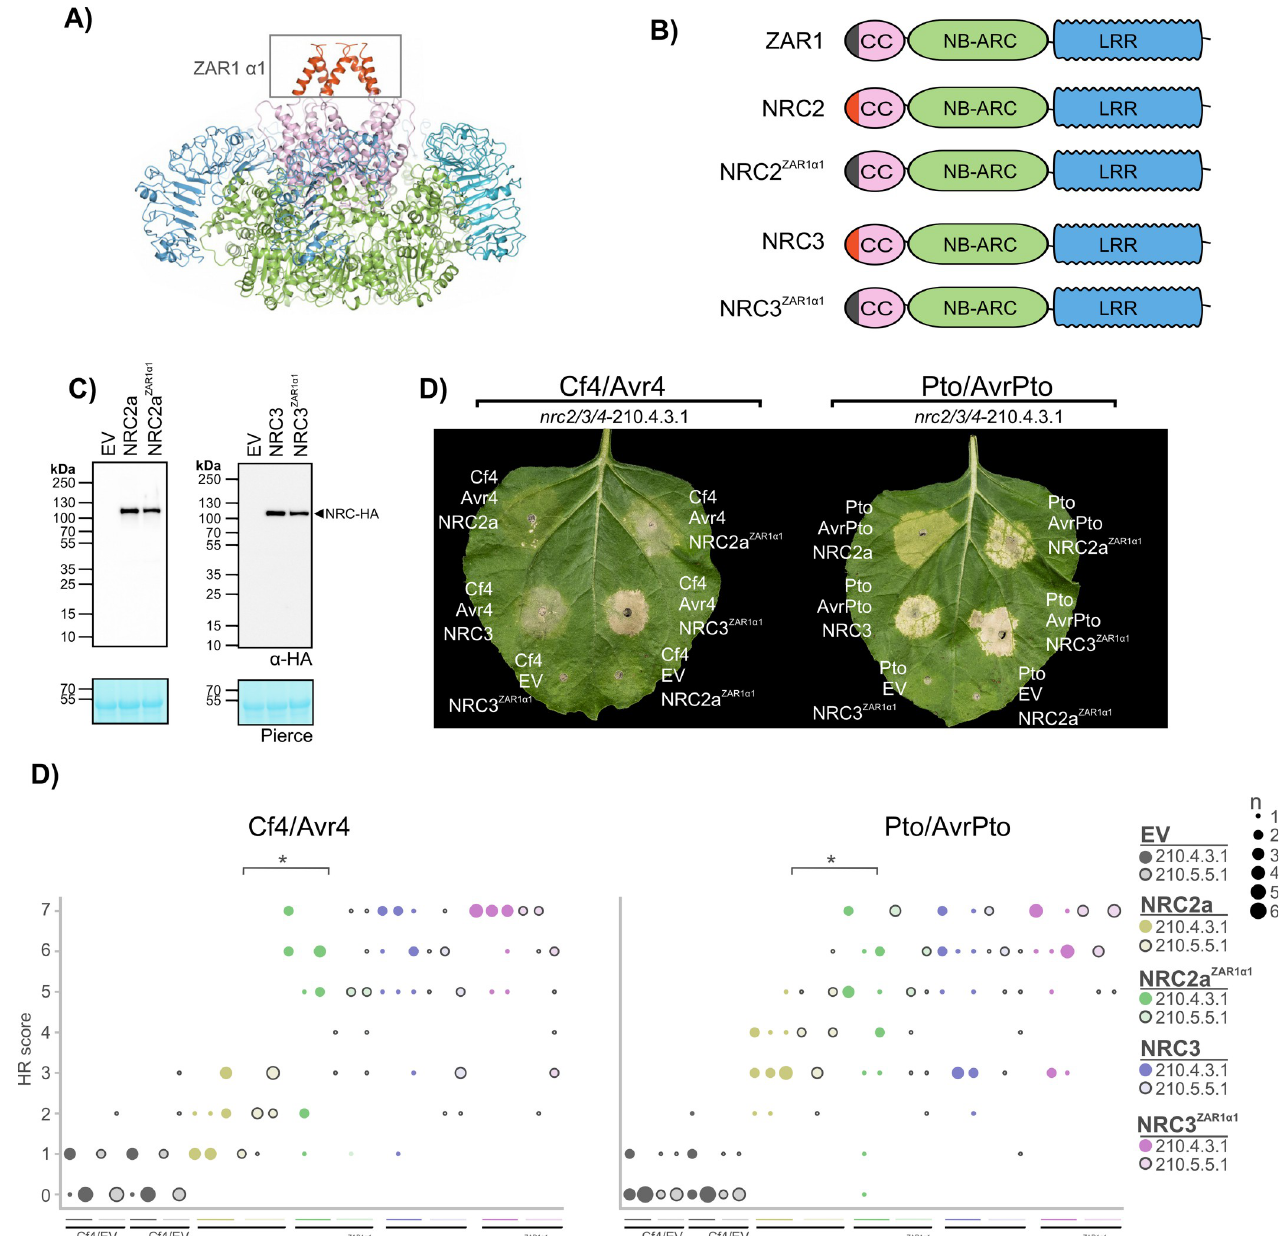
Fig 4. The ZAR1 α 1 helix can functionally replace the NRC2 and NRC3 α 1 helix for Cf-4/Avr4-triggered hypersensitive cell death. A ) Structure of the ZAR1 resistosome with the N-terminal α 1 helix highlighted. B ) Schematic representation of ZAR1, NRC2, NRC3, and the respective NRC2 ZAR1 α 1 and NRC3 ZAR1 α 1 chimaeras in which residues 1–17 and 1–21 are replaced by residues 1–17 from ZAR1, respectively. C ) NRC ZAR1 α 1 helix chimaeras accumulate to similar levels as wild-type NRC proteins. Immunoblot analysis of transient NRC-6xHA accumulation 5 days after agroinfiltration in wild-type N . benthamiana plants. D ) NRC ZAR1 α 1 helix chimaeras can complement Cf-4/Avr4 and Pto/AvrPto-triggered hypersensitive cell death in the N . benthamiana nrc2/3/4 CRISPR lines. Representative N . benthamiana leaves infiltrated with appropriate constructs were photographed 7–10 days after infiltration. The receptor/ effector pair tested, Cf-4/Avr4 and Prf (Pto/AvrPto), are labelled above the leaf of NRC CRISPR line nrc2/3/4 -210.4.3.1. The NRC tested, NRC2 and NRC3, are labelled on the leaf image. To ensure the NRC ZAR1 α 1 helix chimaeras were not autoactive when expressed with either Cf-4 or Pto an EV control was taken along. A representative leaf of the independent nrc2/3/4 -210.5.5.1 CRISPR line is shown in S8E Fig ) Quantification of hypersensitive cell death. Cell death was scored based on a 0–7 scale between 7–10 days post infiltration. The results are presented as a dot plot, where the size of each dot is proportional to the count of the number of samples with the same score within each biological replicate. The experiment was independently repeated three times. The columns correspond to the different biological replicates. Significant differences between the conditions are indicated with an asterisk ( � ). Details of statistical analysis are presented in S8 Fig .